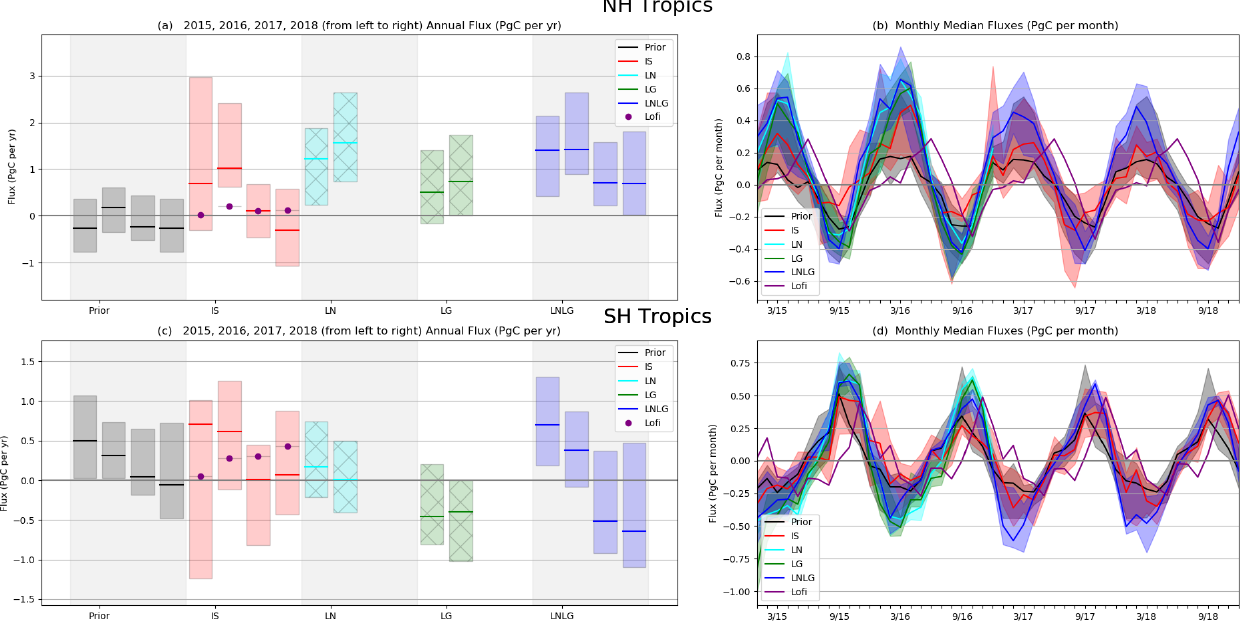
Figure 9. Same as Fig. 6 but for the tropical band: northern tropics (a, b) with latitudes from 0–23 ◦ N and southern tropics (c, d) with latitude from 23–0 ◦